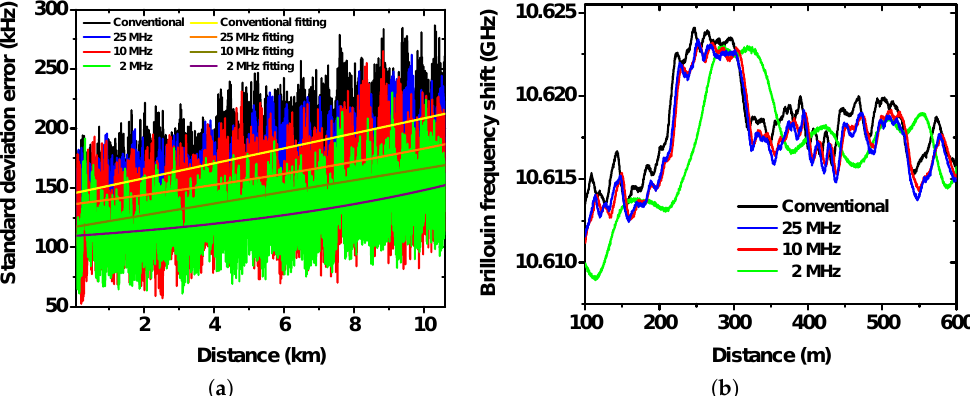
Figure 5. Experimental measurement using RF lowpass filtering: ( a ) Standard deviation error versus distance, solid lines represent the exponential fitting; ( b ) Detection of the strain